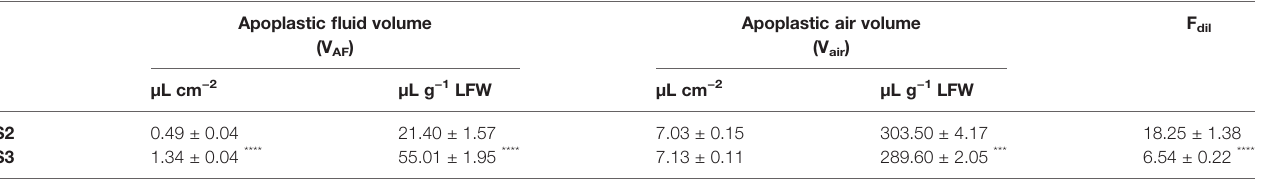
TABLE 1 | Apoplastic volumes occupied by fl uid (AF) and air in S2 and S3 leaves.